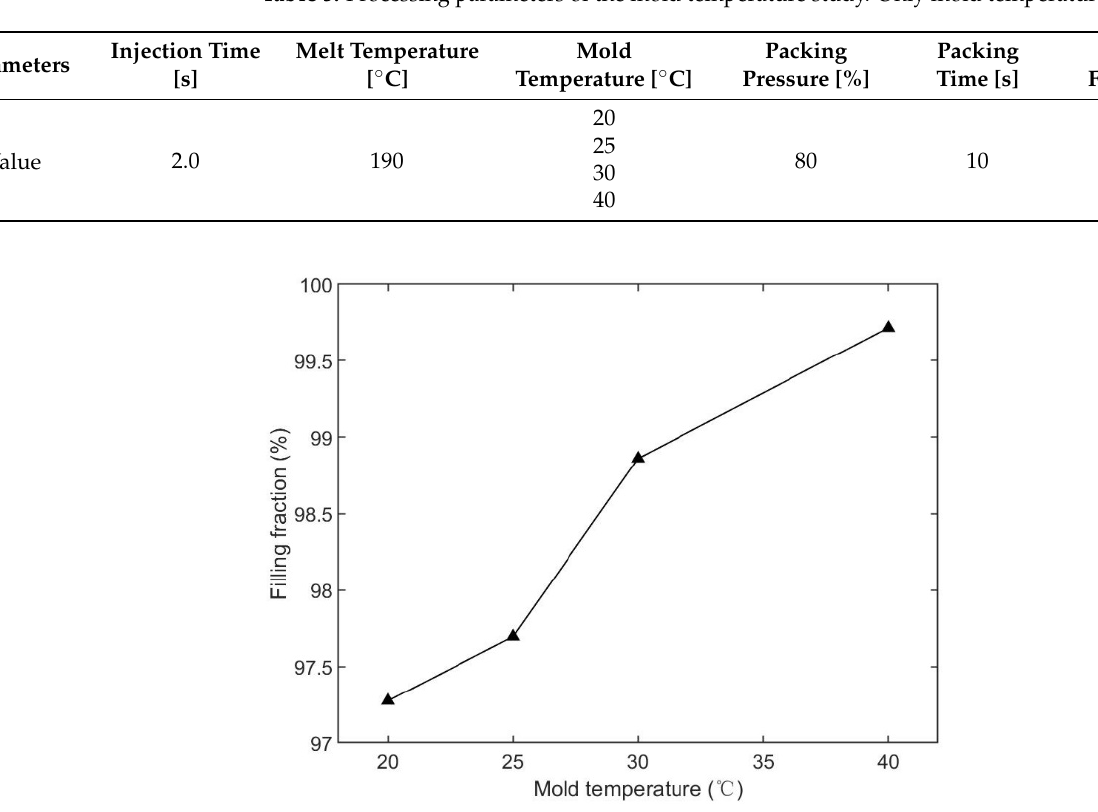
Table 5. Processing parameters of the mold temperature study. Only mold temperature was changed.